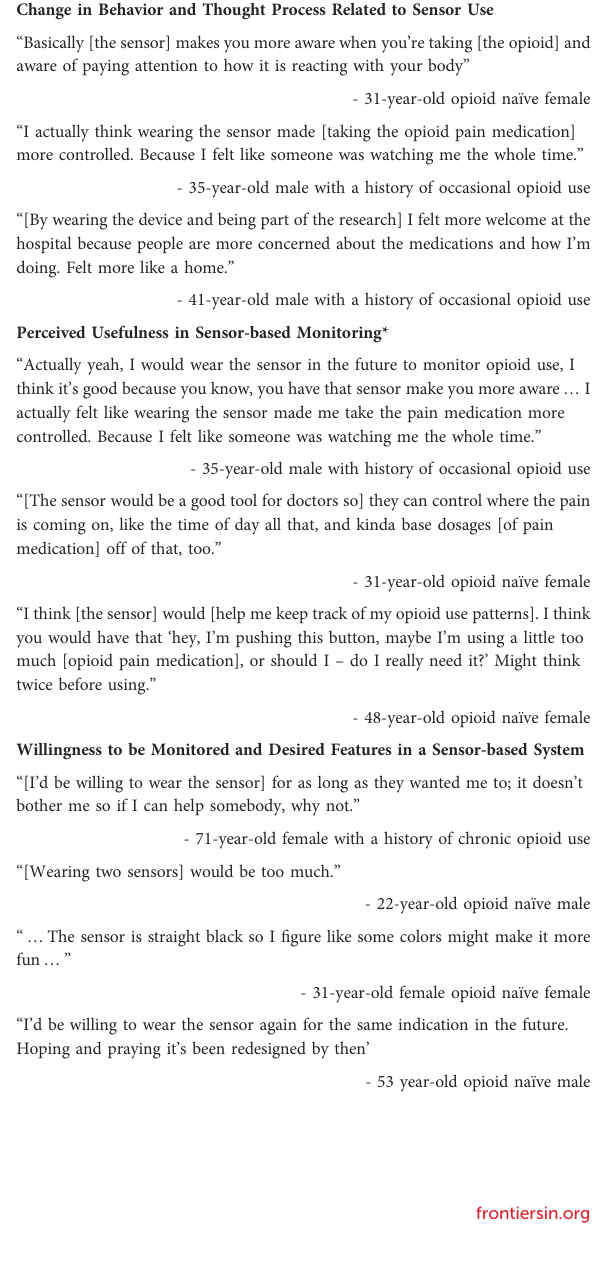
TABLE 2 Exemplar participant quotes from the fi ve main study